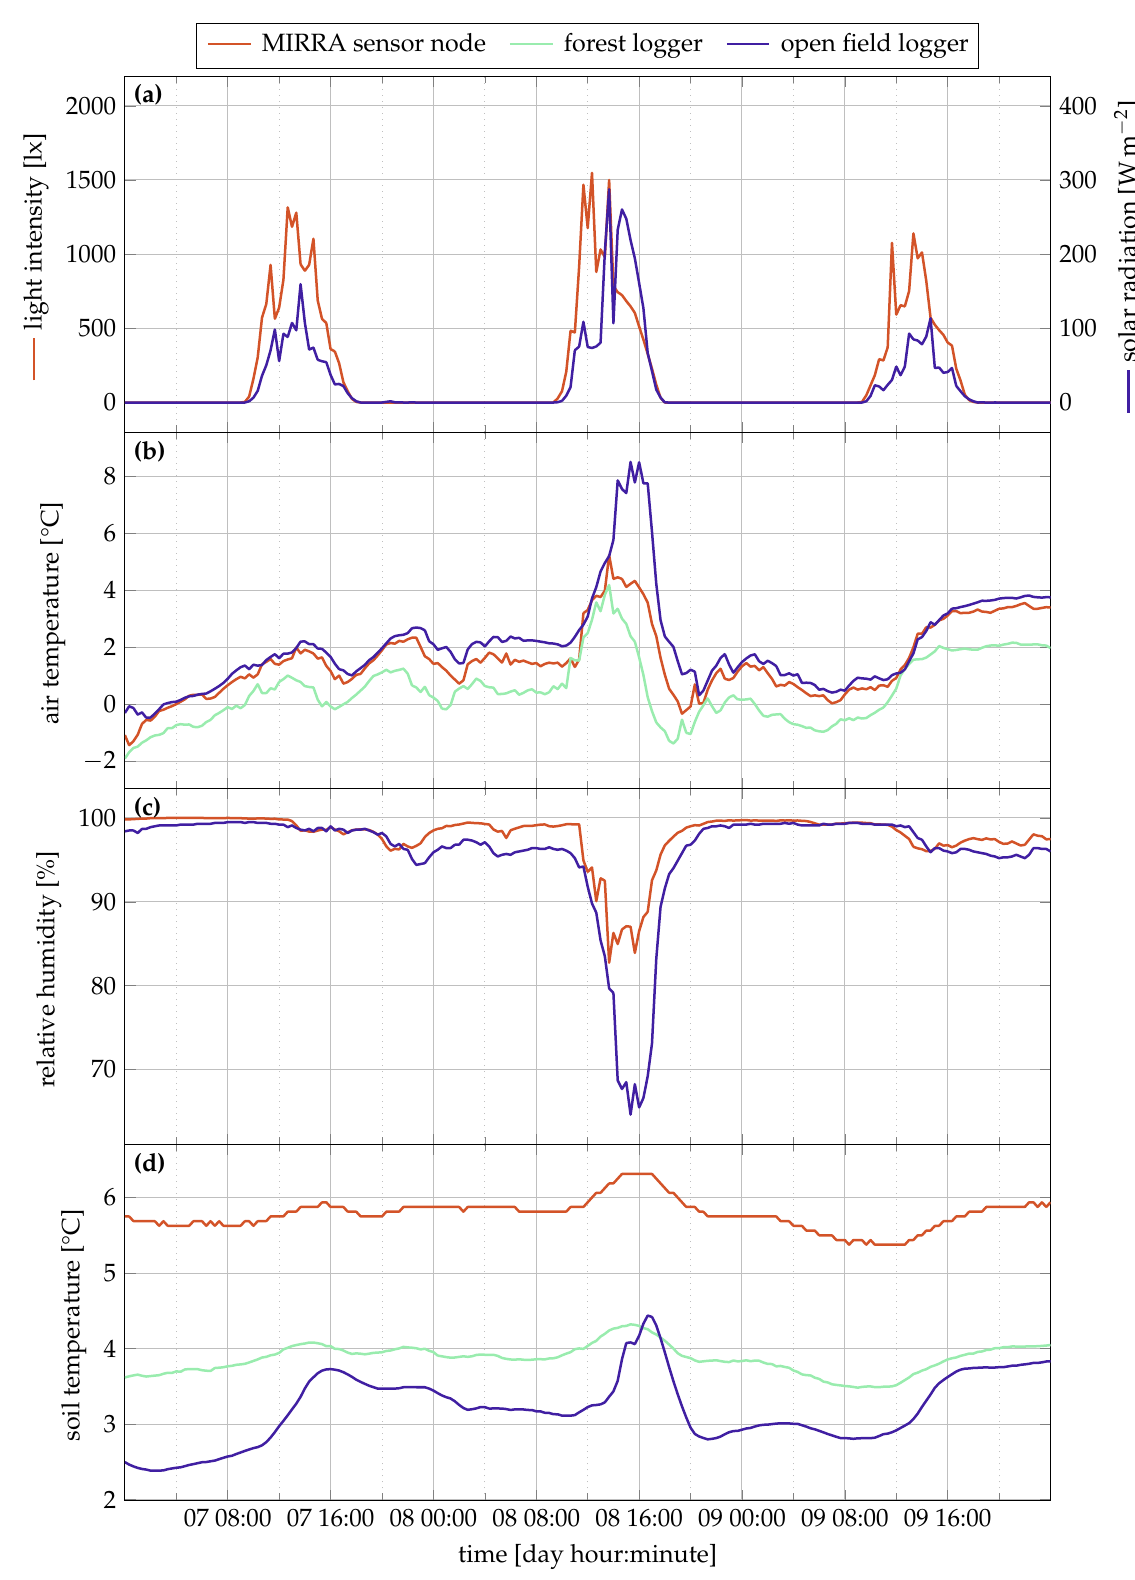
Figure 5. Detailof measurement data between 7 and 10 December 2020. Each of the subfigures details a separate quantity: ( a ) Light intensity in lx (left axis) and Wm − 2 (right axis); ( b ) air temperature; ( c ) relative humidity and ( d ) soil